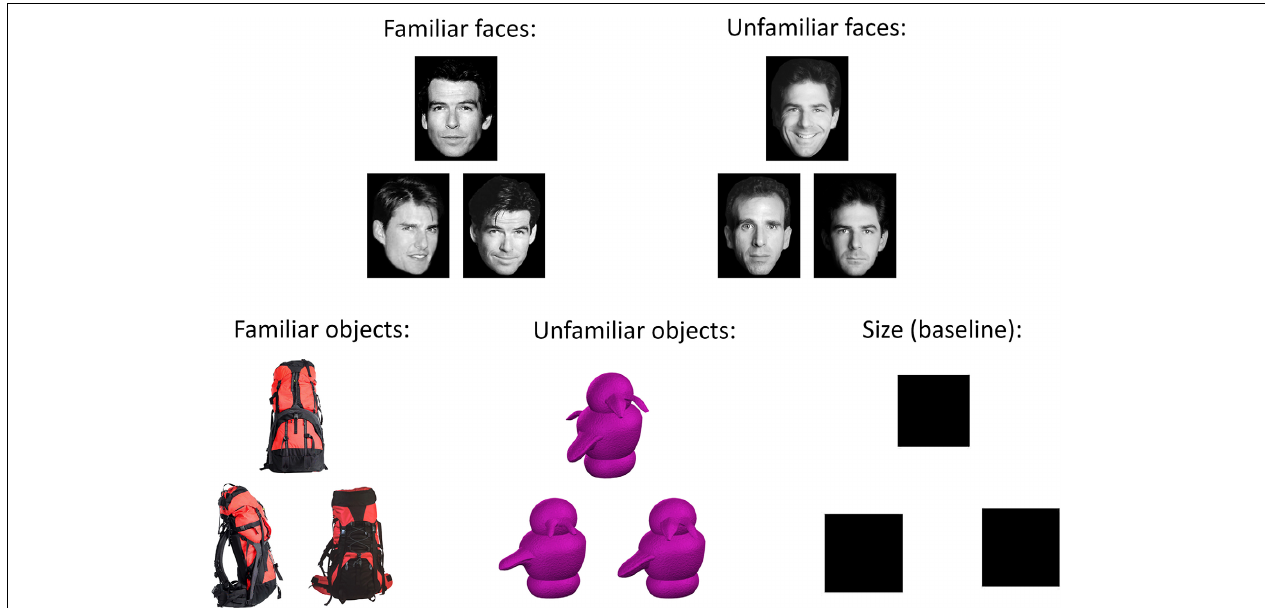
FIGURE 1 | Example stimuli from five conditions in the oddity discrimination task. On each trial, participants were presented with a set of threetrial-uniqueitems.Twooftheseitemswerepicturesofthesamestimulus shown from different viewpoints, while the remaining item was a picture of a slightly different item shown from another viewpoint. Participants were asked toselectthedifferentitem(the“odd-one-out”).Stimulioneachtrialwereeither